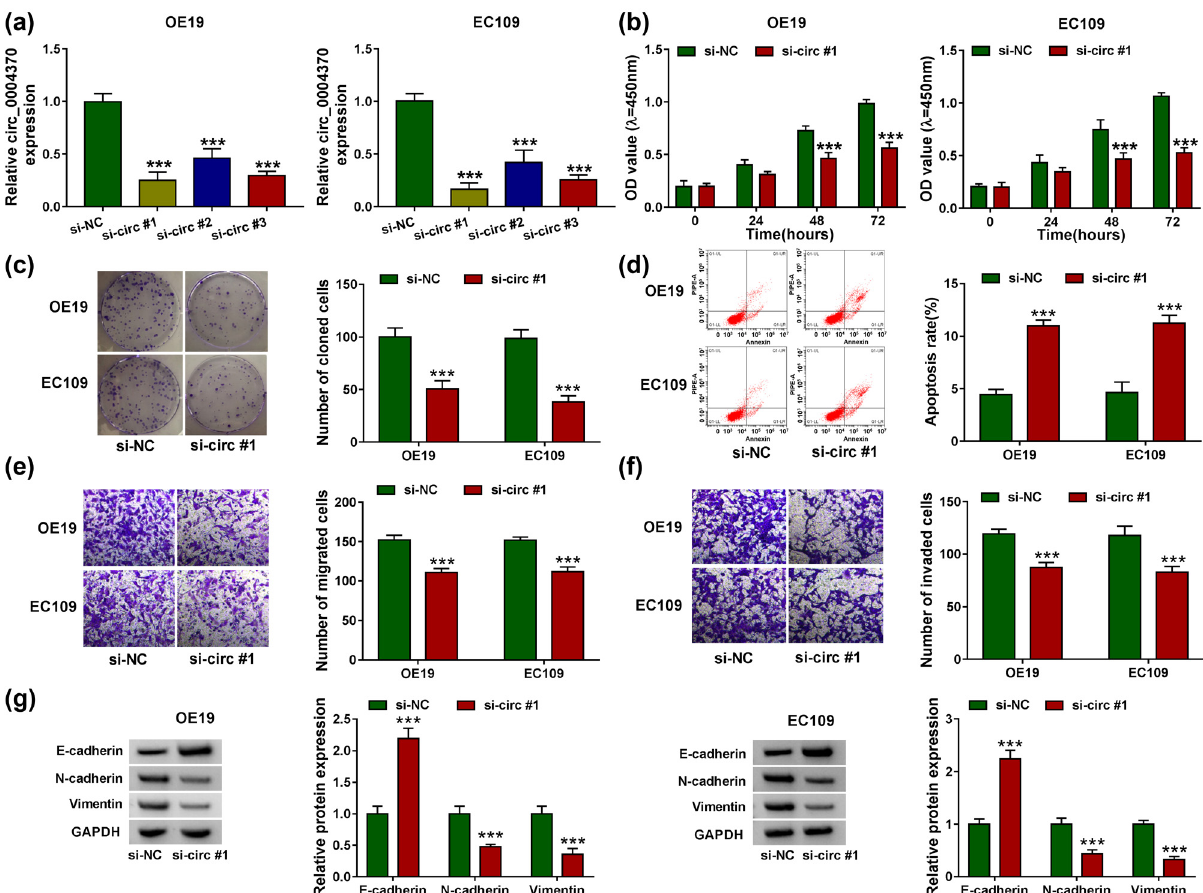
Figure 2: Circ_0004370 regulated EC progression in vitro . ( a ) The relative expression of circ_0004370 in cells was measured by RT - qPCR after transfected with si - NC, si - circ #1, si - circ #2, and si_circ #3 individually. ( b ) Cell proliferation of OE19 and EC109 cell lines was evaluated by CCK - 8 assay. ( c ) Cell cloning of OE19 and EC109 cell lines was evaluated by Colony formation assay. ( d ) Cell apoptosis of OE19 and EC109 cell lines was evaluated by fl ow cytometry assay. ( e and f ) Cell migration and invasion of OE19 and EC109 cell lines were analyzed by transwell assay. ( g ) Relative Protein expression of the EMT marker E - cadherin, N - cadherin, and Vimentin was evaluated by western blot analysis in OE19 and EC109 cells. *** P <